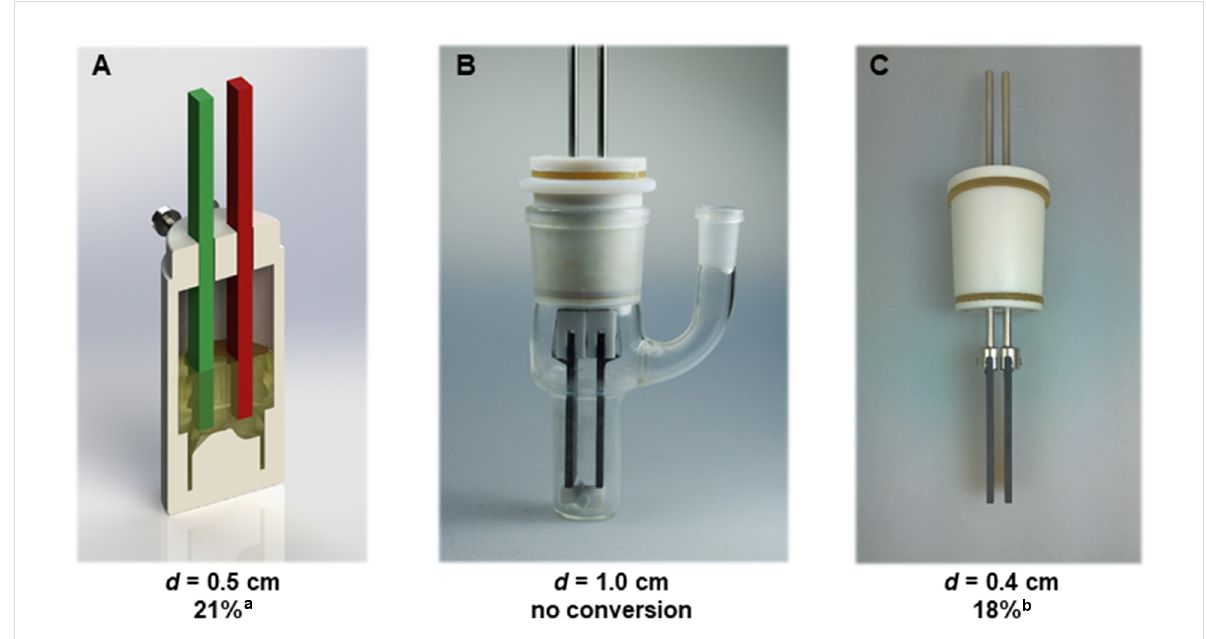
Figure 2: Influence of the electrode distance; a 1 H NMR yield; b isolated